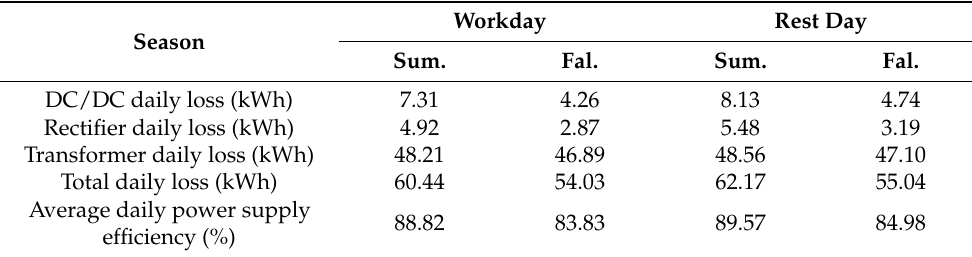
Table 4. The loss calculation